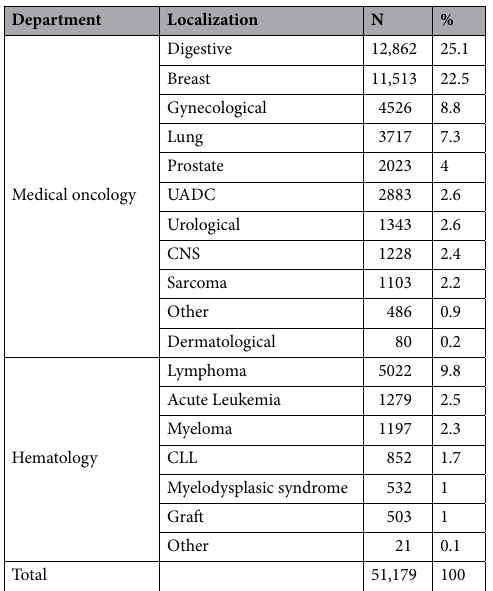
Table 2. Distribution of prescriptions by cancer location. UADC upper aero digestive cancer, CNS central nervous system, CLL chronic lymphocytic leukemia.